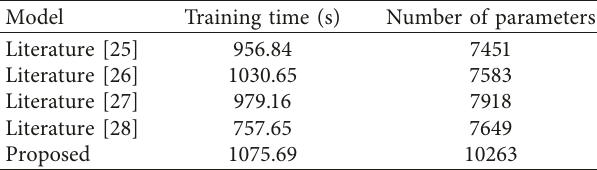
Table 4: Experimental results of different algorithms in data sets.